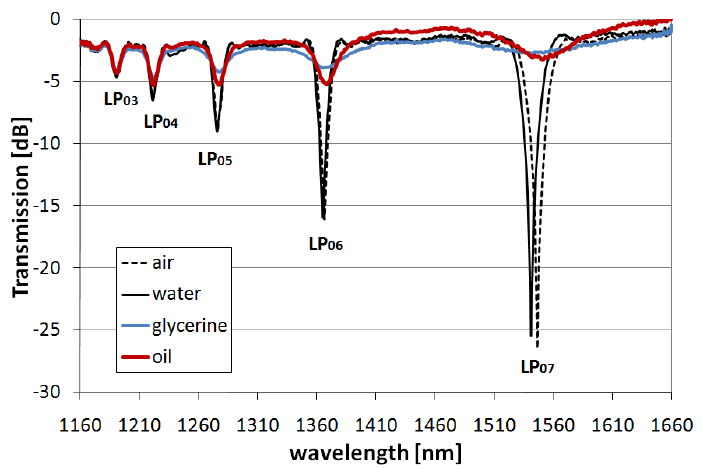
Figure 1. Influence of the external RI on the spectrum of LPGs (Λ = 375 μm) written in PS 1250/1500 fiber. RIs (n ) of water, glycerine and oil used as external medium D are 1.3334, 1.4746 and 1.4793,